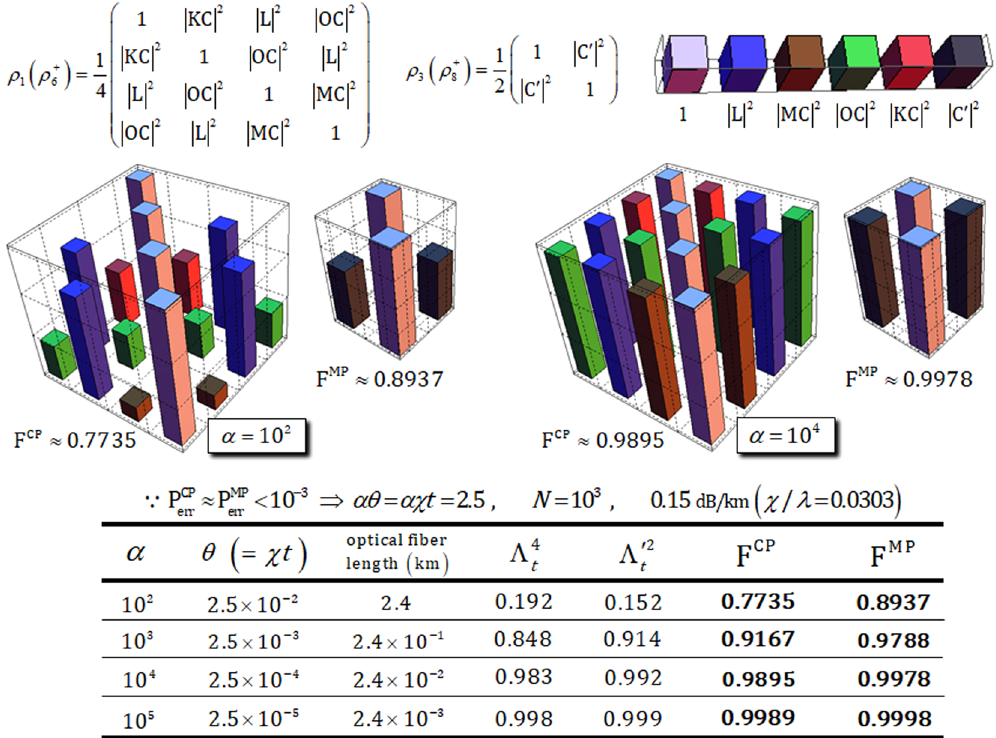
( ρ 3 or ρ + ) of output state, which applied 6 8 4 ( Λ′ 2 ), of the t t